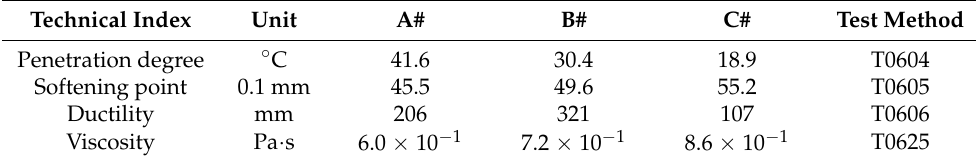
Table 4. Simulation of the basic performance index of aging